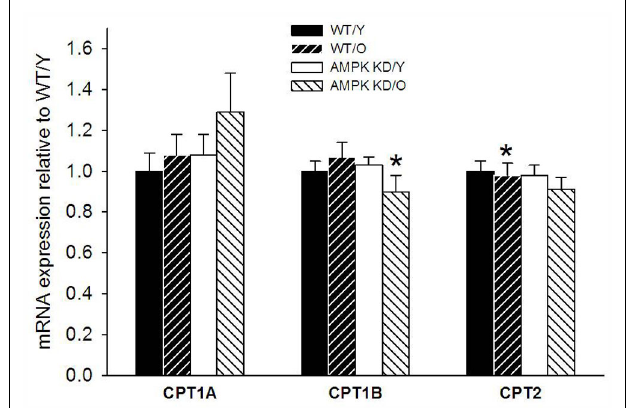
FIGURE 1 | Mitochondrial respiratory capacity in heart muscle samples from wild type mice (WT) and dominant negativeAMPK α 2 (AMPK KD) mice. Young (Y: 19–22weeks) and old (O: 76–91weeks) mice were studied in both groups. State 3 respiration was measured with two different substrate protocols. Malate, ADP, and octanoylcarnitine (Oct.car) or malate, ADP, and palmitoylcarnitine (Pal.car).Values are mean ± SE. *Different from WT/Y ( P < 0.05).